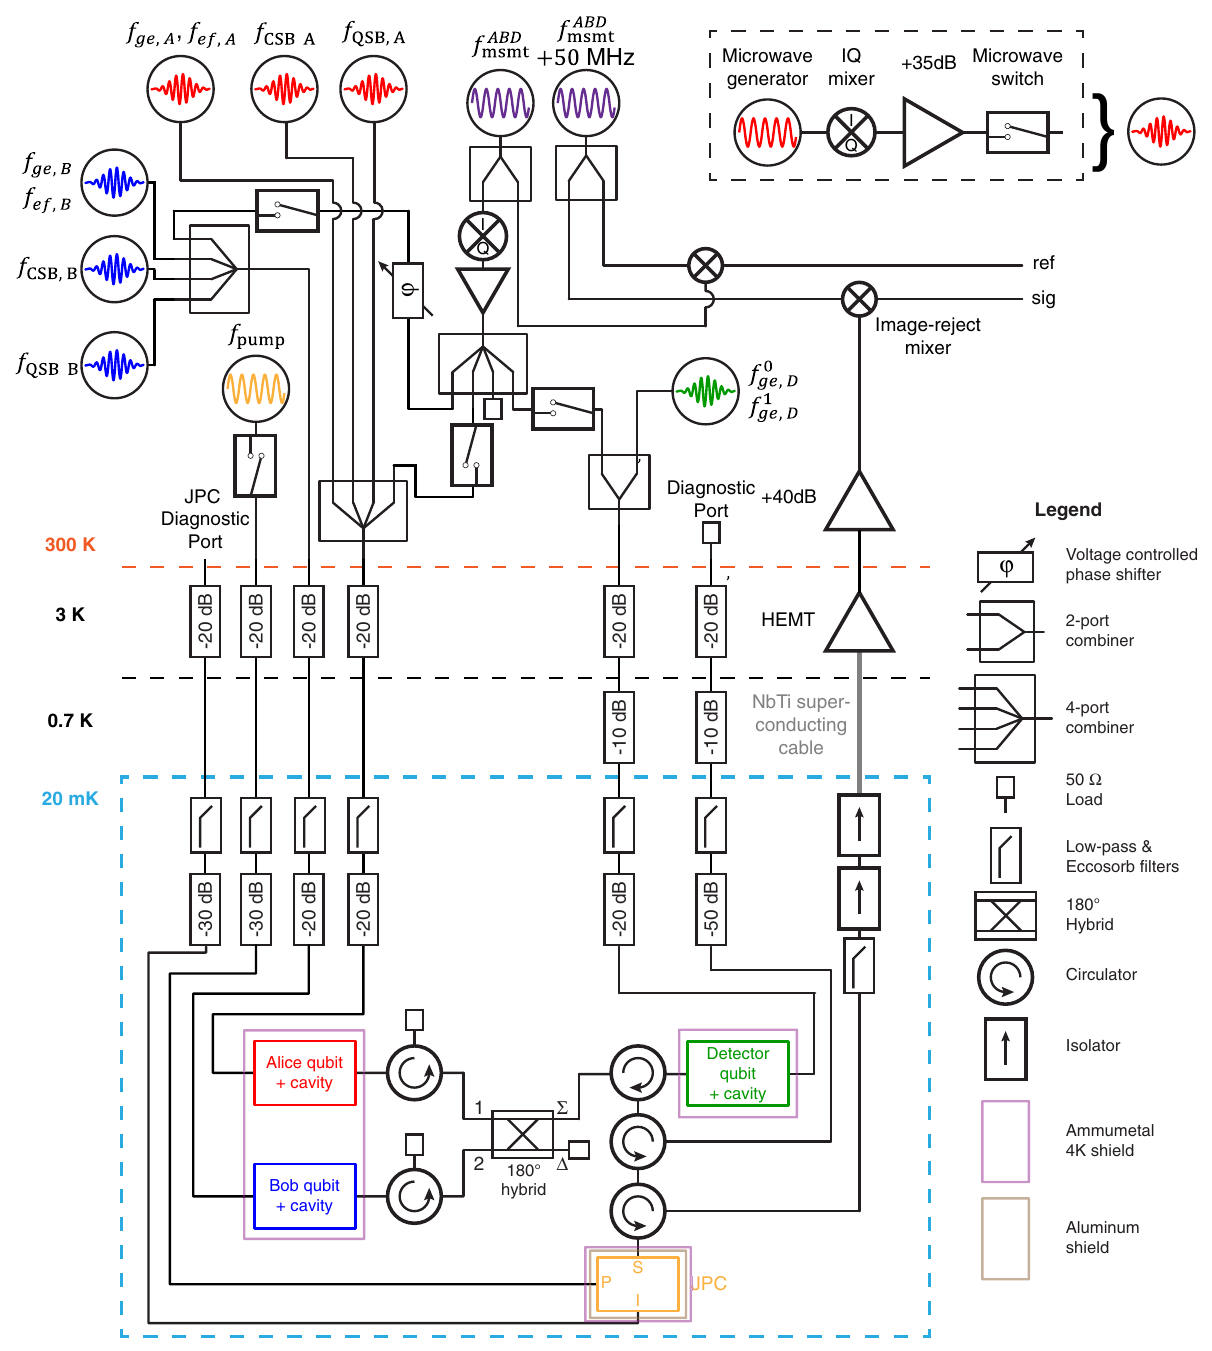
FIG. 5. Detailed experimental setup. The experiment (bottom) was cooled down on the base stage ( < 50 mK) of a dilution refrigerator. Input lines carrying signals to the systems were attenuated and filtered using commercial low-pass filters and homemade lossy Eccosorb filters. The room-temperature electronics used to produce and shape the input signals are shown at the top of the figure. The basic setup to produce shaped signals was a microwave generator driving an IQ mixer followed by an amplifier and finally a switch to gate the signal (box in top-right corner). The signals were shaped by channels from four arbitrary waveform generators (AWGs) (not shown), which also provided the digital markers for the switches. Copies of this setup (denoted by the shorthand notation of a circle with a shaped pulse) were used to generate the drive signals (color-coded) for three modules: Alice (red), Bob (blue), and the detector (green). The Alice and Bob modules had four inputs each: the cavity readout tone, the qubit signals, and the pair of sideband pulses for photon generation. On the other hand, the detector module had two inputs: the cavity readout tone and the qubit signals. All the modules were read out using a single output line that had multiple stages of amplification. High-fidelity single-shot readout was enabled by the JPC amplifier. The output signals were downconverted and then digitized and demodulated along with a room-temperature reference